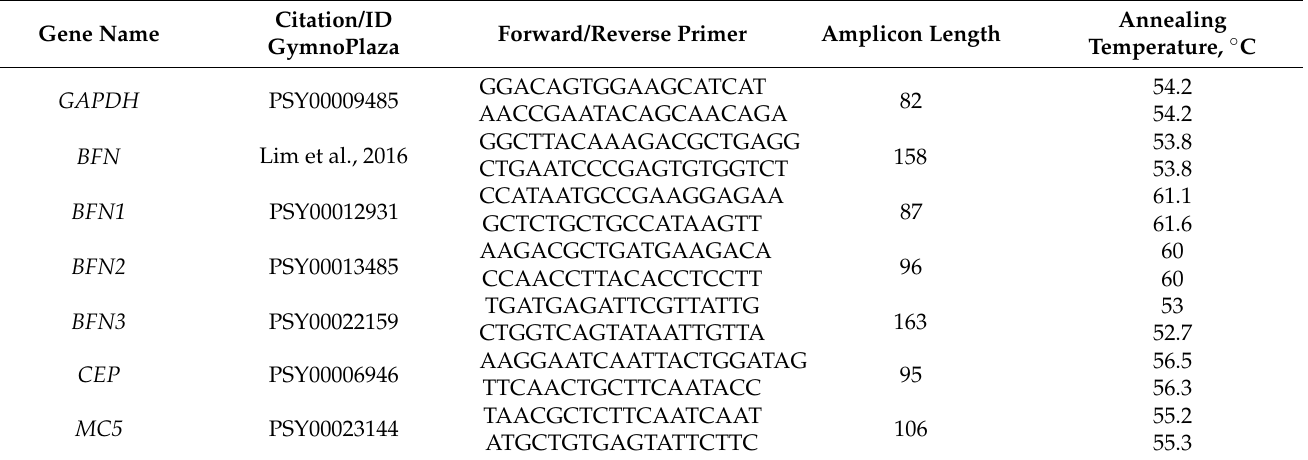
Table 1. Primer sequence for RT-PCR